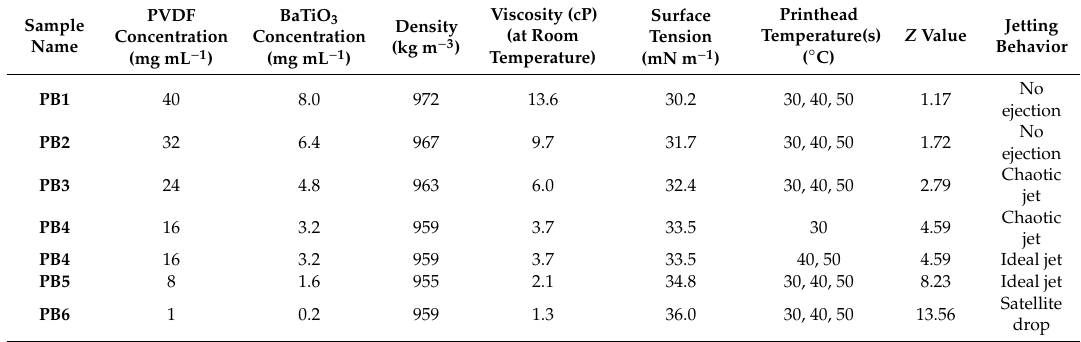
Table 1. Properties of fabricated inks and their jetting behavior at a constant trigger voltage of 30